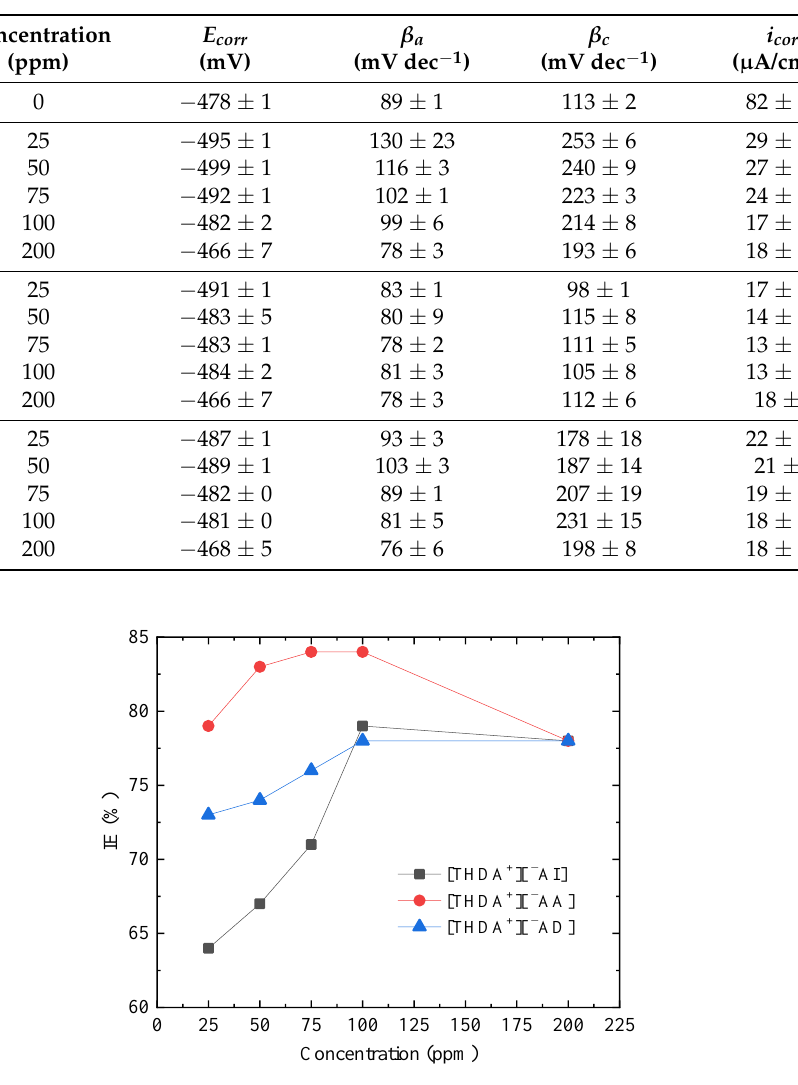
Figure 3. Corrosion IE behavior for API X52 steel in 0.5 M HCl at different concentrations of ILs with cation [THDA + ].